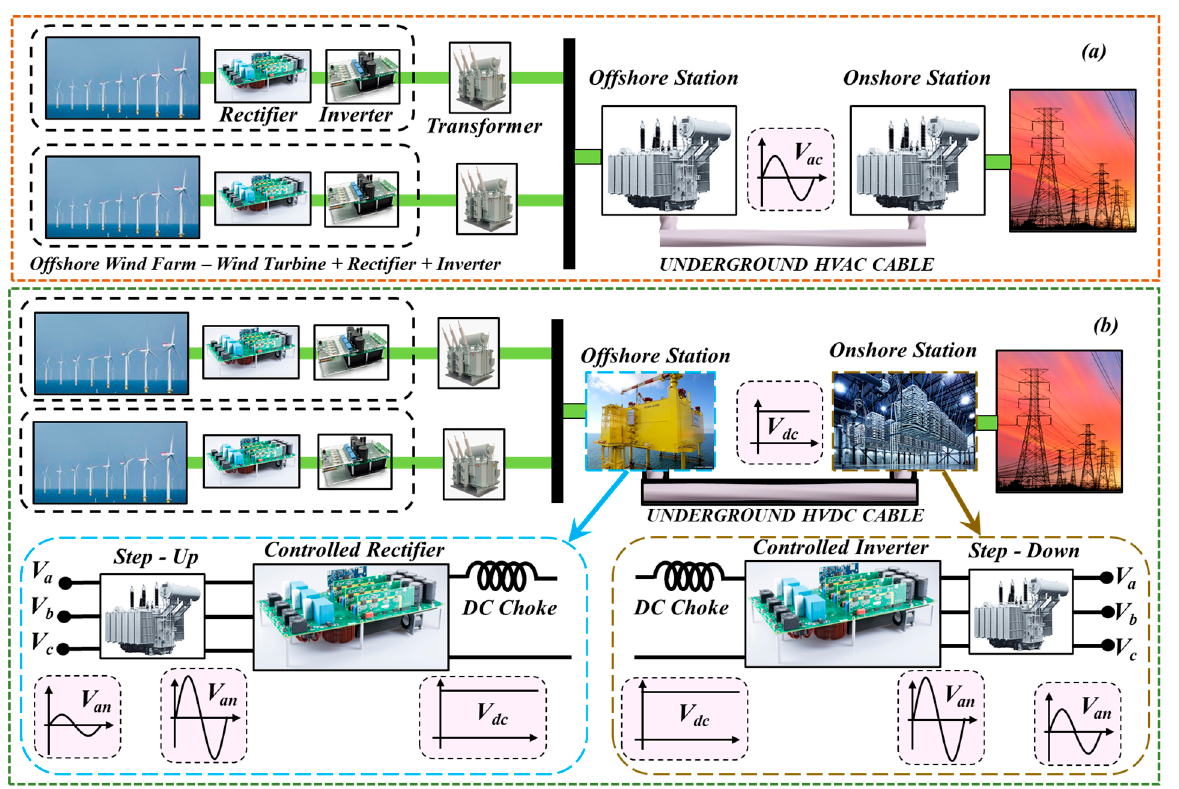
Figure 2. Offshore wind power plant layout for ( a ) HVAC and ( b ) HVDC transmission.